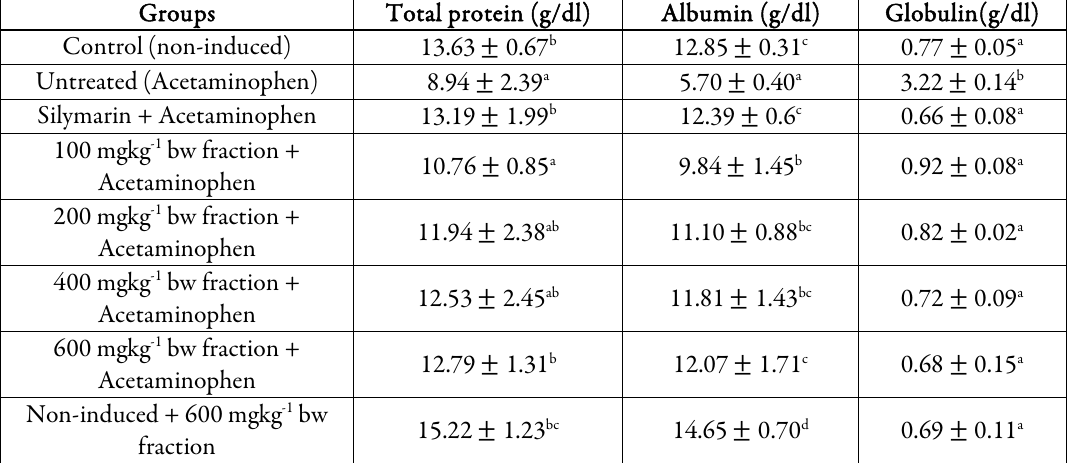
Table 5. Total protein, albumin and globulin concentration (g/dl) in the serum of the rats